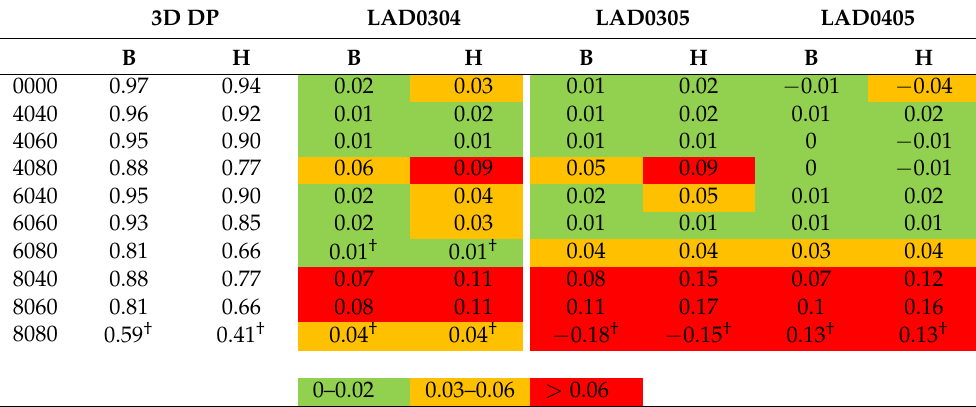
Table 5. Virtual FFR values at baseline (B) and hyperaemia (H) for the left anterior descending (LAD) artery and the original digital phantom (DP), the reconstruction using views 3 and 4 (LAD0304), 3 and 5 (LAD0305), and finally, 4 and 5 (LAD0405). The † symbol indicates cases for which the pressure converged, but the residual for the continuity equation remained higher than the convergence threshold.